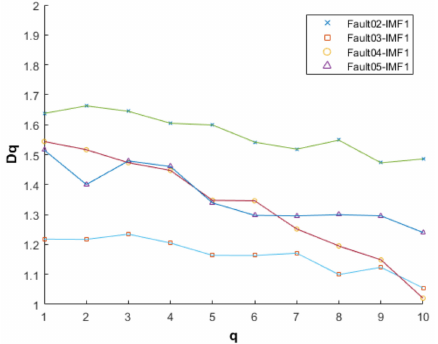
Figure 13. IMF1‑VMD box fractal dimension map.